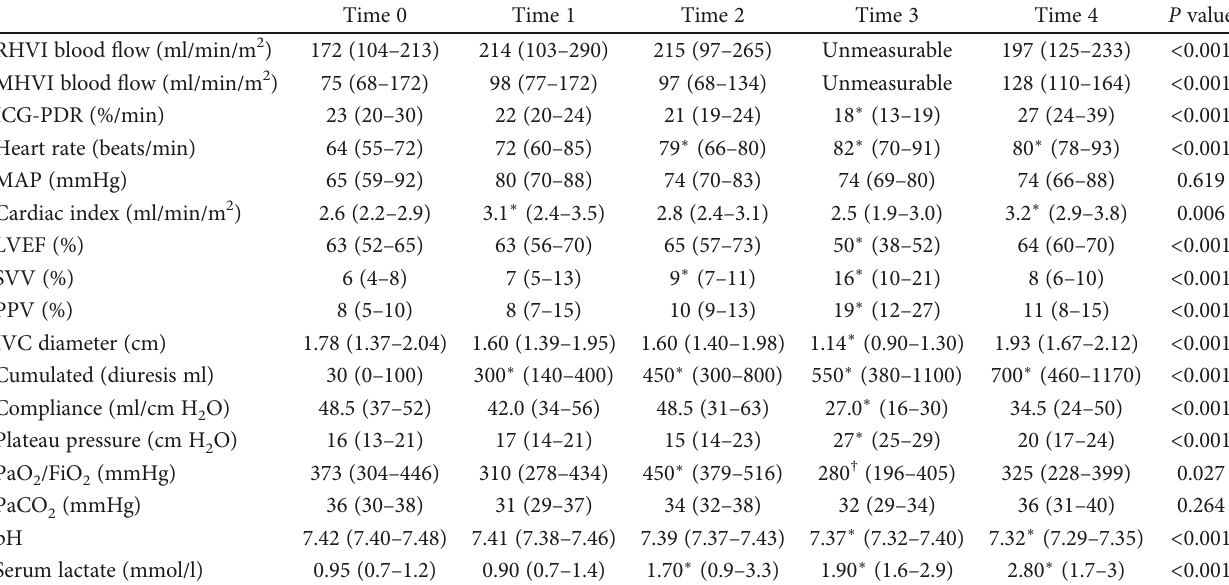
Table 1: Intraoperative changes in hepatic, systemic, respiratory, and blood gas